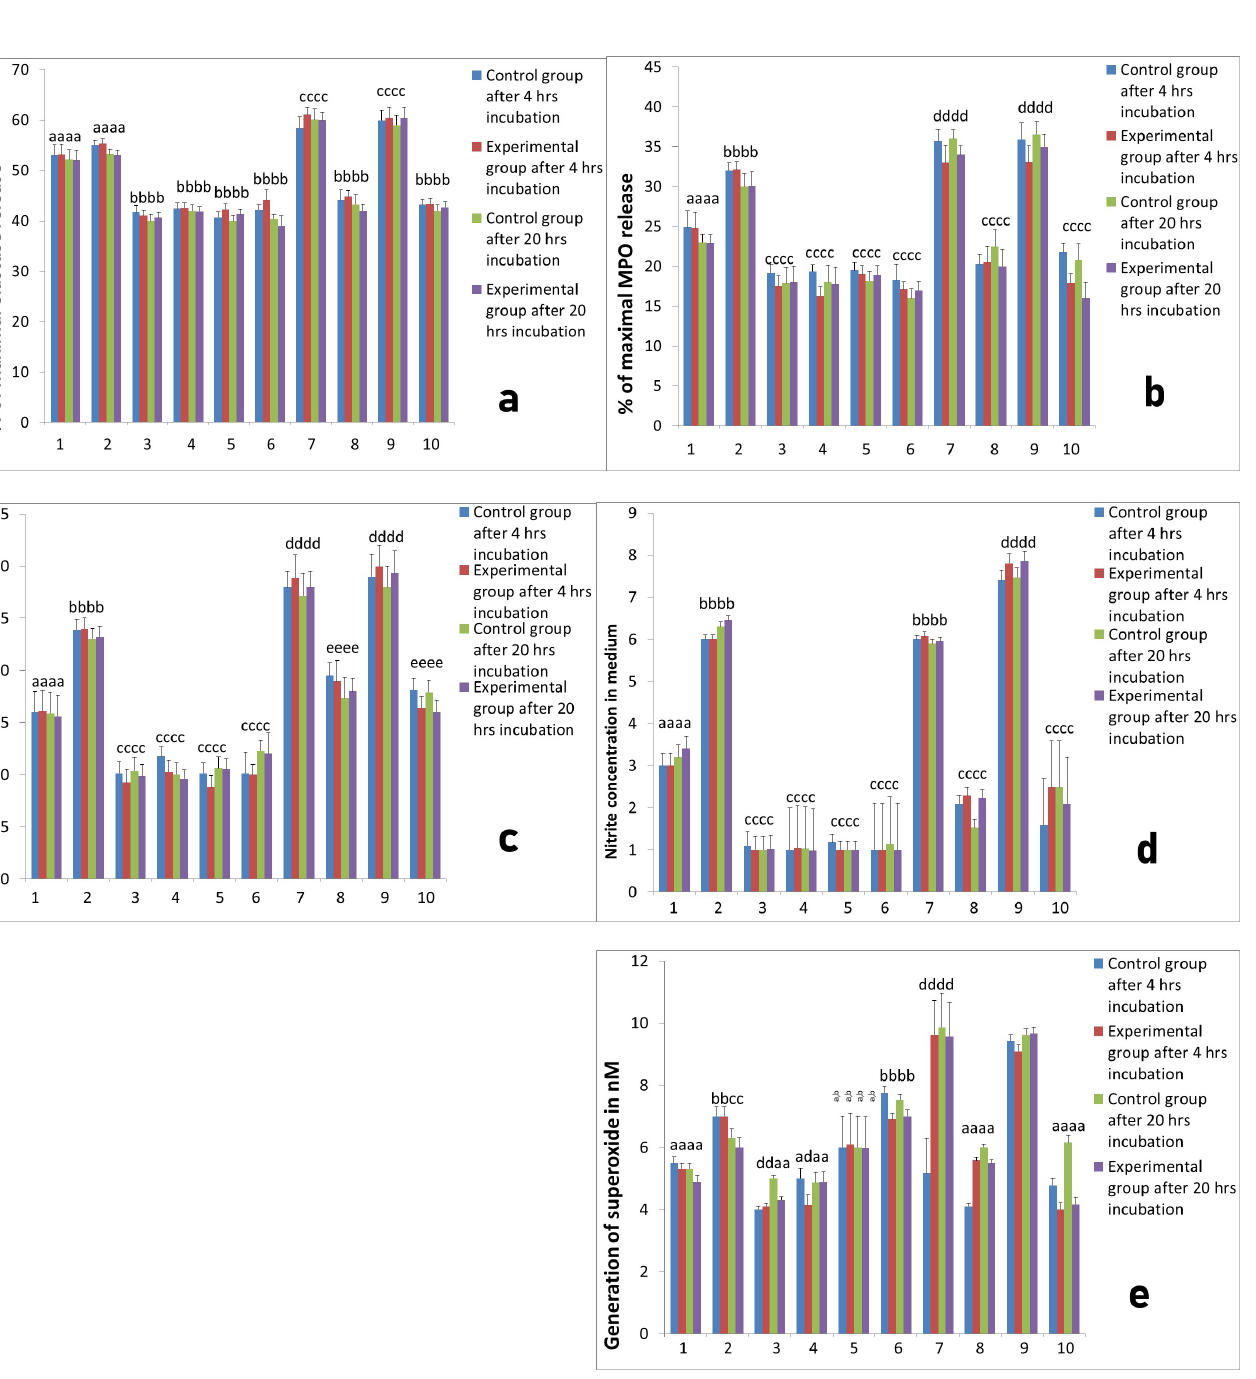
Figure 8. The response of neutrophils isolated 4 months after implantation to different PRP-derived products with or without additional stimulation with LPS. Cultures were incubated for 4 h or for 20 h at 37 ◦ C and 5% CO 2. Data present mean values ± SE of at least three replicates for each bar. The neutrophil response was assessed with respect to: ( a ) elastase release from neutrophils, ( b ) MPO release, ( c ) ALP release, ( d ) NO generation, ( e )-superoxide generation. Values marked with different letters differed significantly ( p < 0.05). Legends: 1—neutrophil without stimulation, 2—after stimulation LPS, 3—after stimulation PPP from L-PRP, 4—after stimulation PPP from PURE PRP, 5—after stimulation PPP from L-PRP with LPS, 6—after stimulation PPP from PURE PRP with LPS, 7—after stimulation L-PRP, 8—after stimulation PURE PRP, 9—after stimulation L-PRP with LPS, 10—after stimulation PURE PRP with LPS